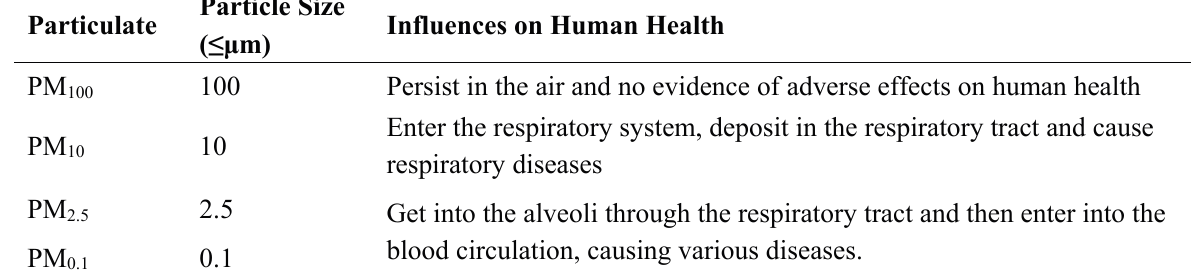
Table 1. Influences of particle size on human